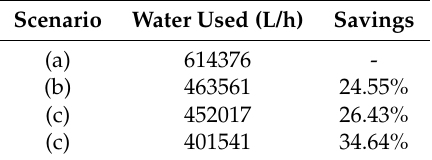
Table 5. Water used per